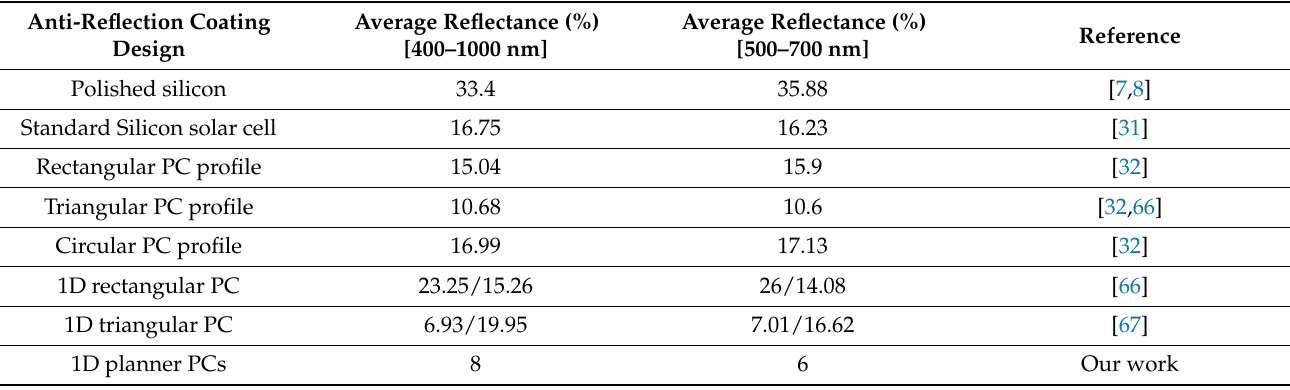
Table 1. The average reflection of antireflection coating designs for the remarkable results found in the literature in comparison with our